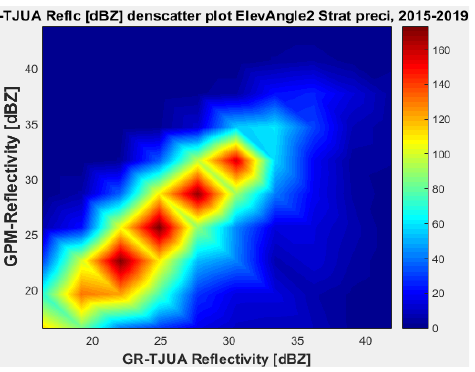
Figure 12. GPM ‐ Ku vs. NEXRAD TJUA for stratiform precipitation (angle 2).